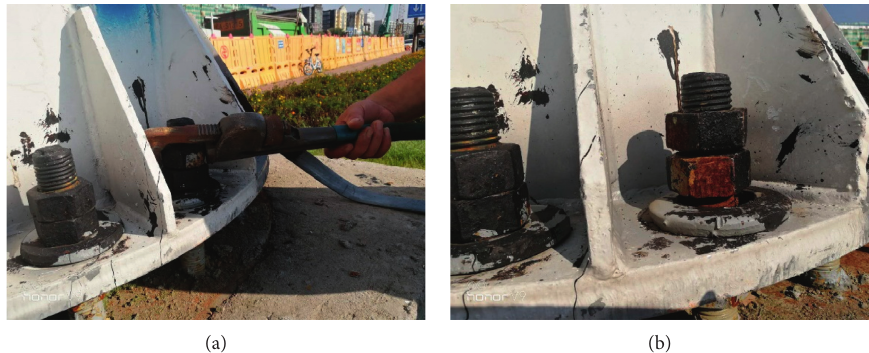
Figure 5: Photograph of bolt loosening of the junction of structure